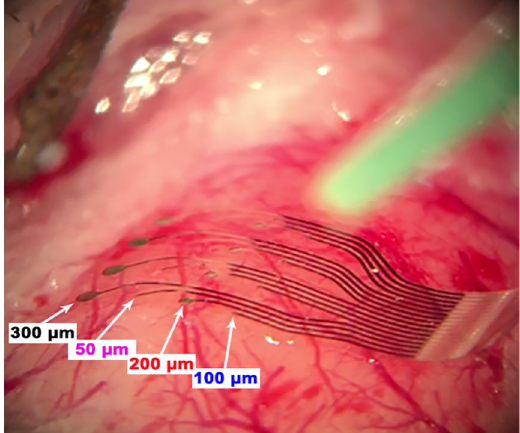
Figure 8. ECoG device implanted over the left barrel cortex of a rat during an acute experiment. The array perfectly adapts to the curvature of the cortex enabling strong biotic/abiotic interface contact. For each position, the location of the largest recorded SEP, identified as the signal source, moves on the electrode color‐coded map consistently with the repositioning of the array on the cortex (Figure 9). When placed close to the signal source, in fact, each electrode diameter is able to record the greatest peak‐to‐peak amplitude. Consequently, the resulting signal‐to‐noise ratio (SNR) values (Figure 9, bottom row) do not depend on the electrodes’ dimensions but are highly correlated to the signal source location and to the intensity of the signal. On the other hand, when only single whiskers are stimulated (Figure 9C), smaller SEP amplitudes and lower SNR values are expected due to the reduced population of neurons involved in the task (with respect to the all‐whisker’s case of Figure 9A,B) rather than to the electrodes themselves.